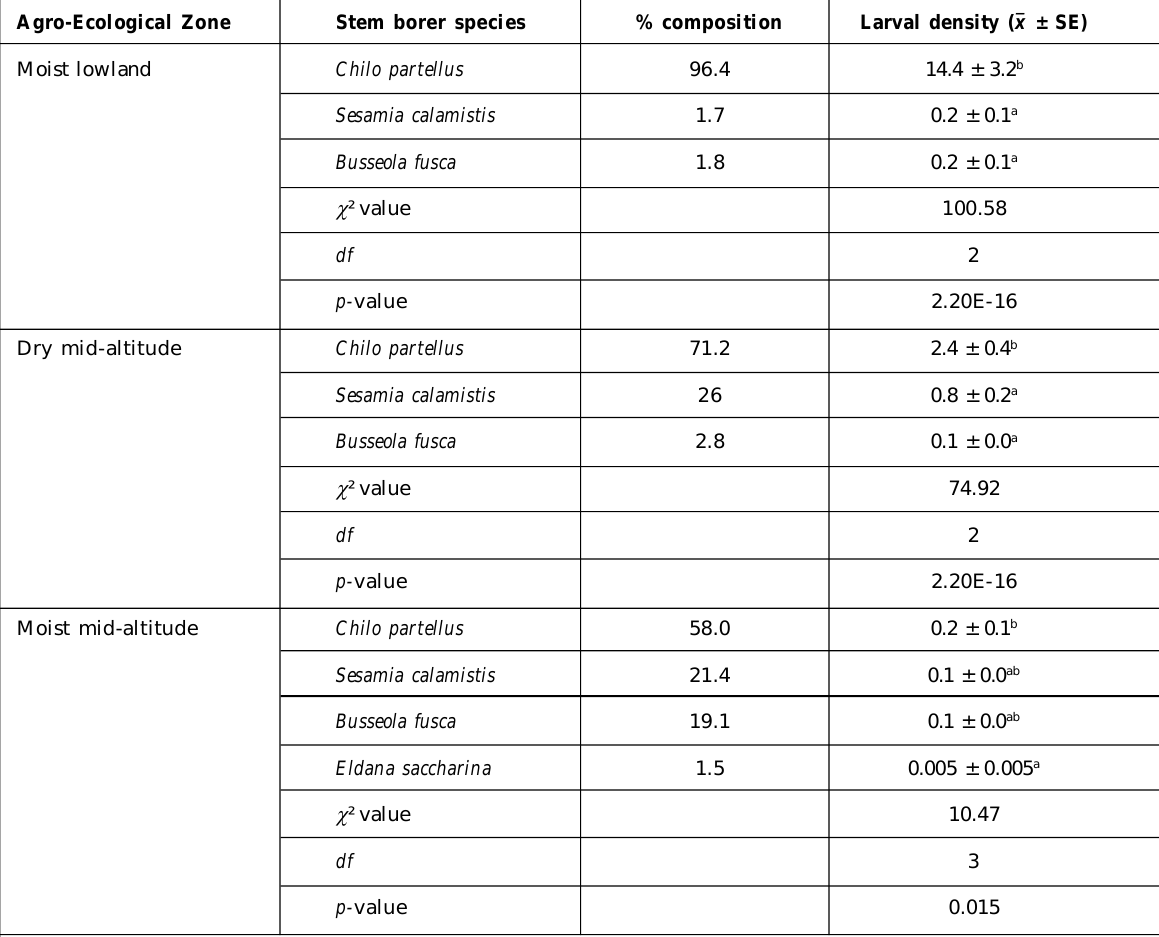
Table 1: Percentage composition and density of stem borer species recovered in the three agro-ecological zones Agro-Ecological Zone Stem borer species % composition Larval density ( x — ± SE) Moist